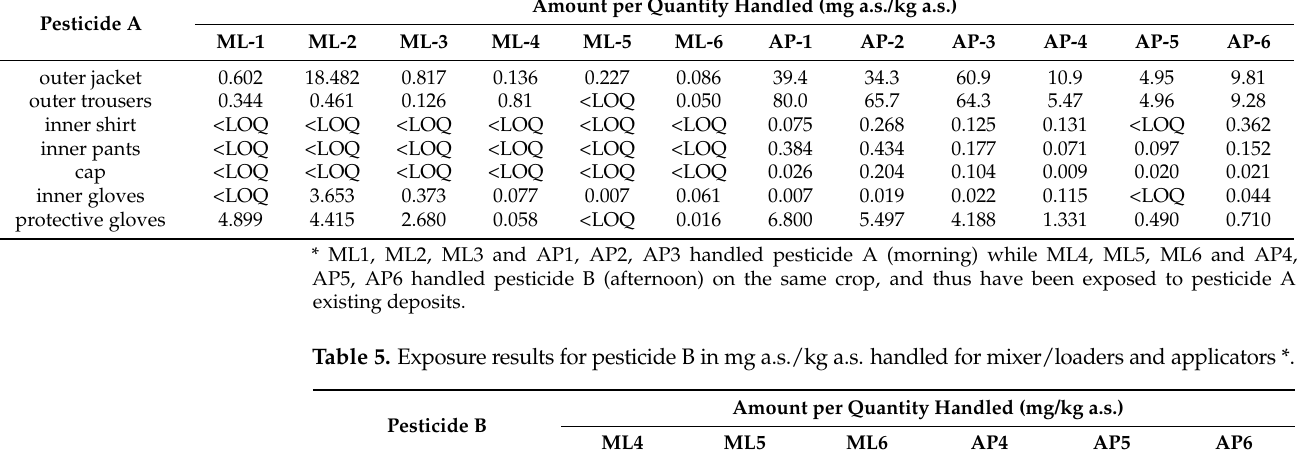
Table 4. Exposure results for pesticide A in mg a.s./kg a.s. handled for mixer/loaders and applicators *. Amount per Quantity Handled (mg a.s./kg a.s.) Pesticide A